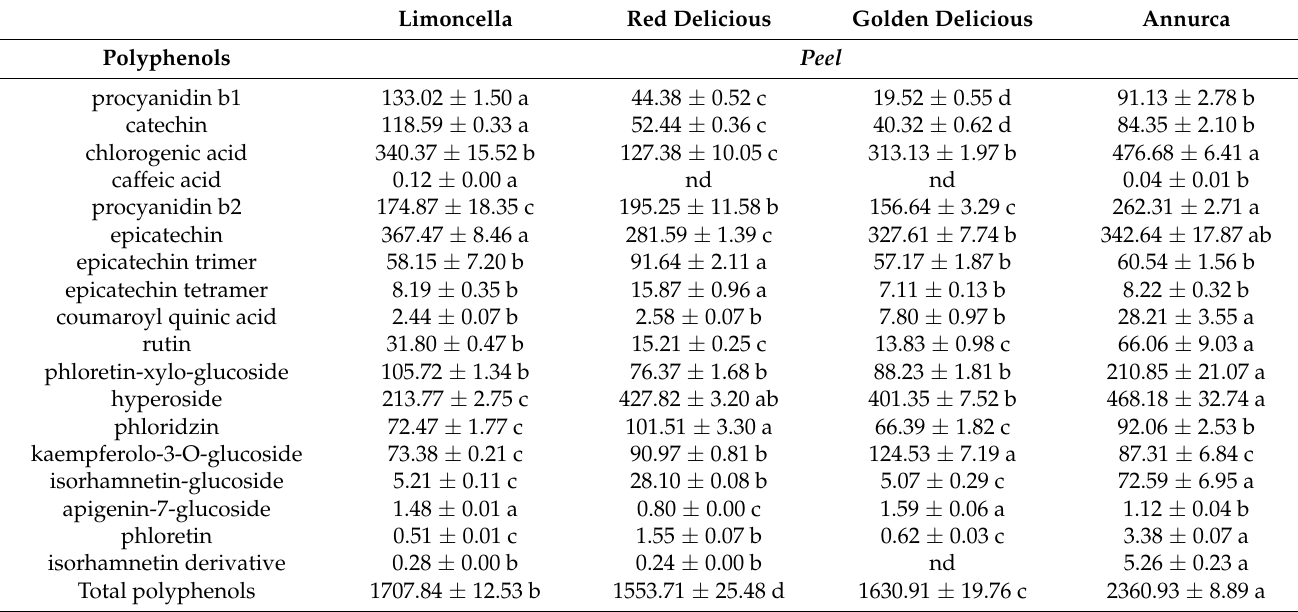
Table 5. Polyphenols content in the peels of “Limoncella,” “Red Delicious,” “Golden Delicious,” and “Annurca” cultivars detected by HRMS-Orbitrap. Values are expressed in µ g/g (dw). Each value represents the mean of three biological and two technical replicates. Different letters denote a significant difference between cultivars by analysis of variance [ANOVA]. Statistical significance was defined as p < 0.05, using Tukey’s post hoc test for mean separation. nd: not